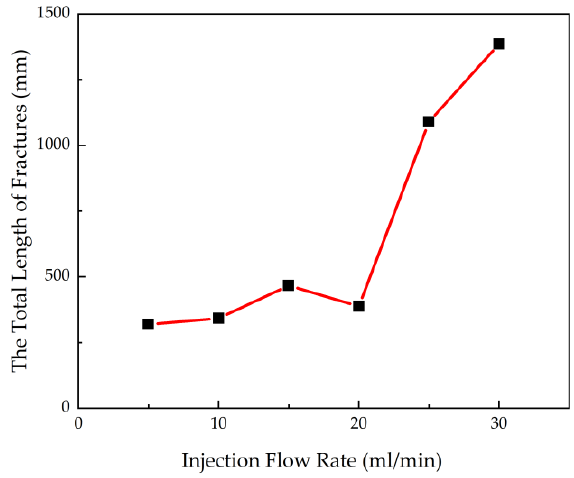
Figure 14. Influence of injection flow rate on the fracture length.